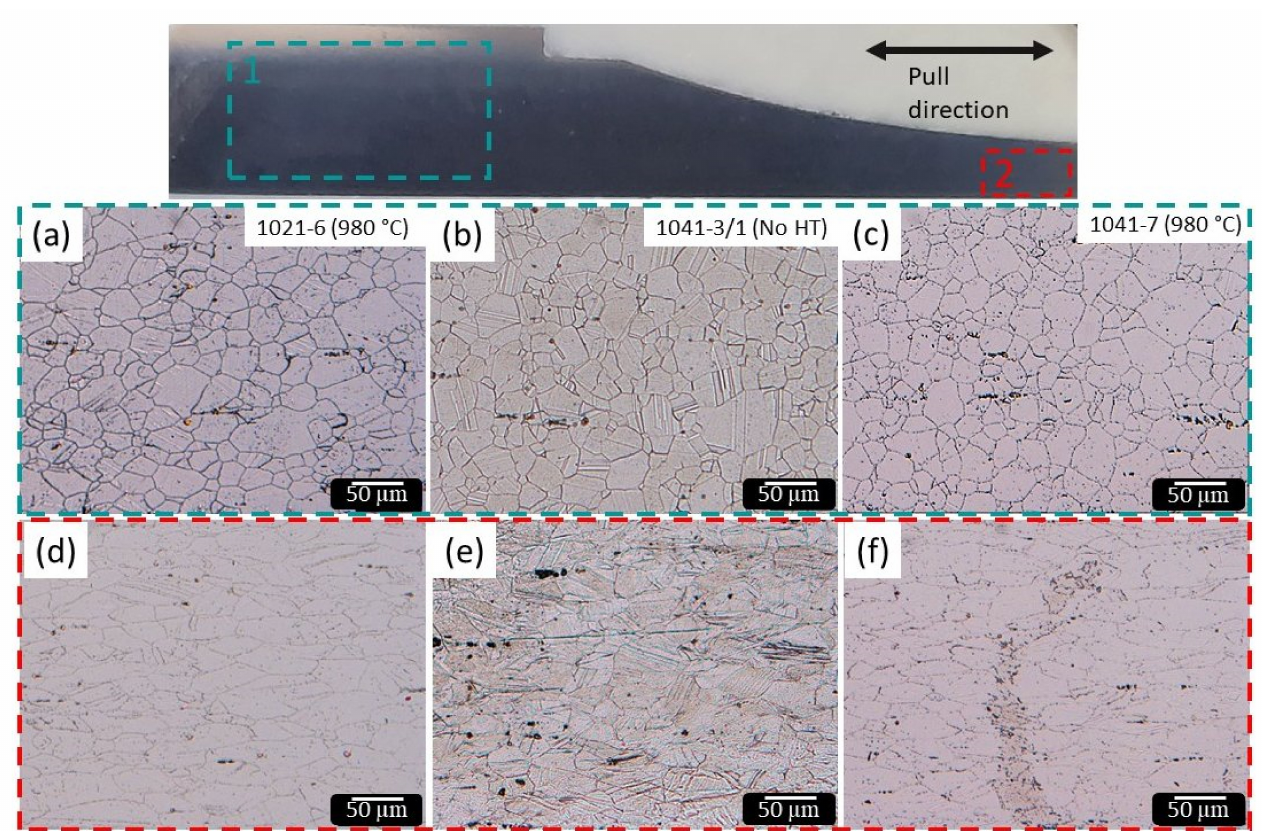
Figure 5. Hourglass specimen with the areas of interest highlighted in the undeformed ( 1 ) and deformed ( 2 ) regions: ( a – c ) show the etched microstructure of the undeformed region and ( d – f ) show the etched microstructure of the deformed region for each